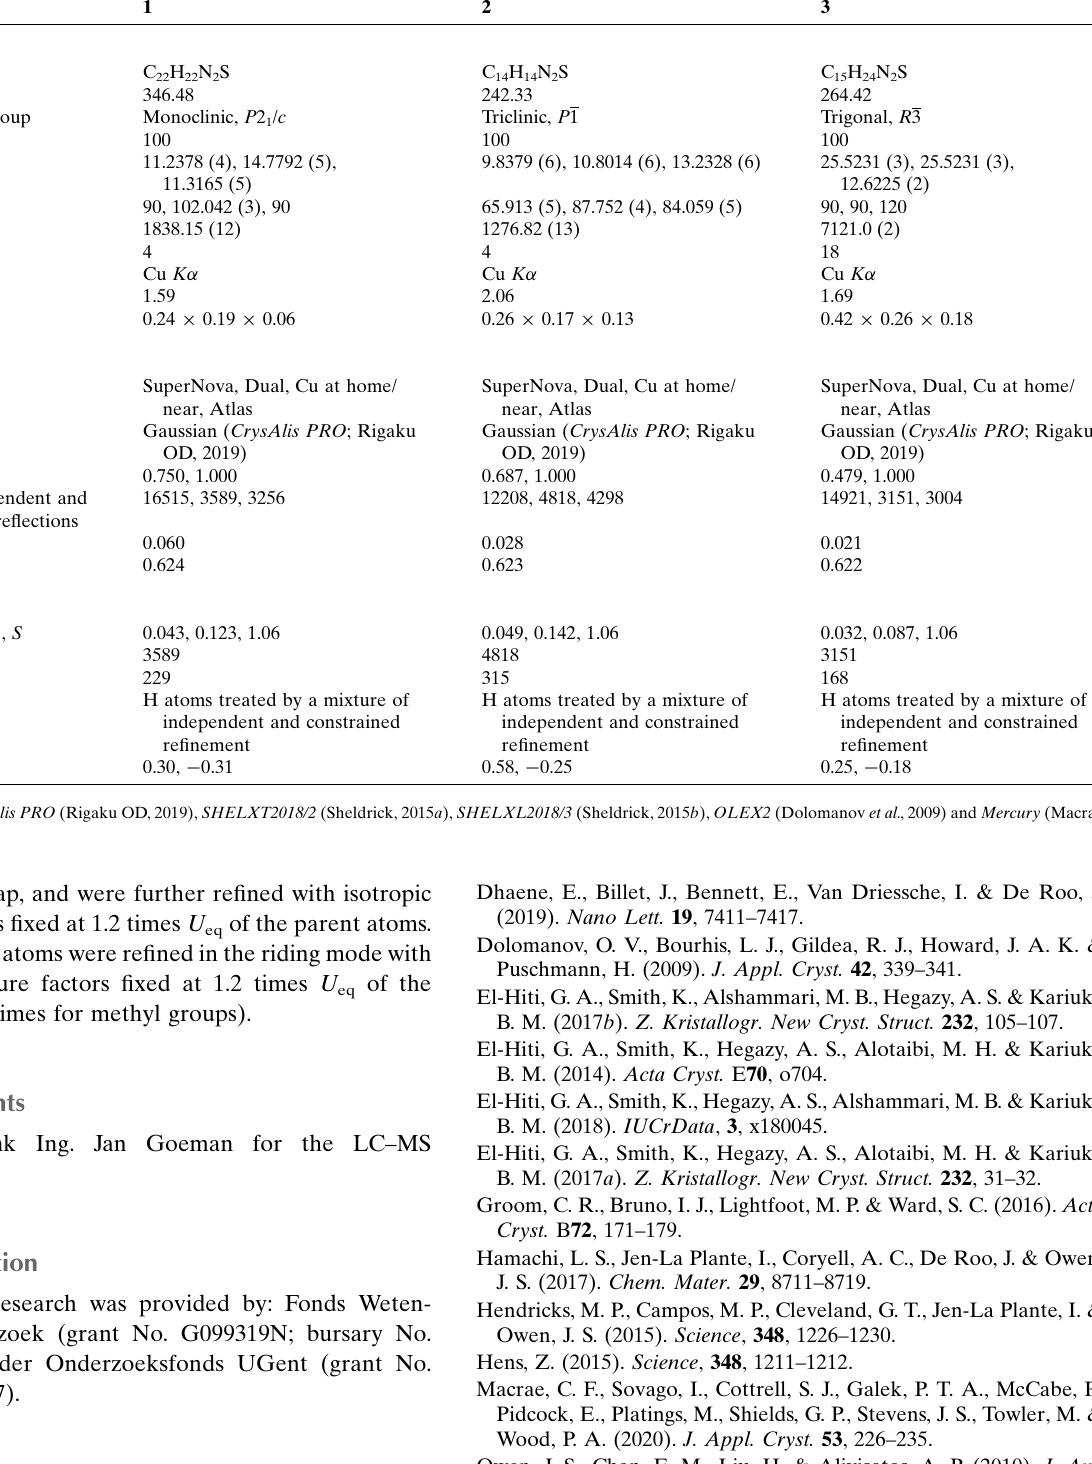
Crystal data Chemical